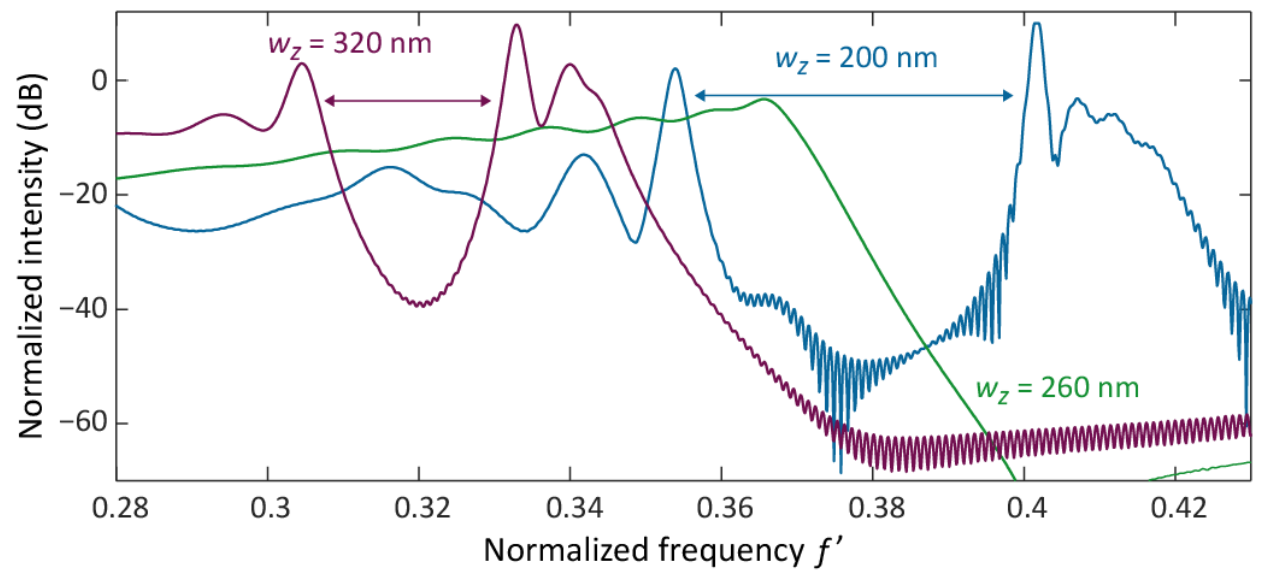
Figure 2. FDTD-calculated normalized intensity after transmission along a chain of 10 nanobricks using waveguides as input and output ports for w z = 200 (blue), 260 (black) and 320 nm (red). The results are normalized with respect to the transmission along a perfect rectangular waveguide. The trend is as follows: the PBG (highlighted by the horizontal lines with arrows) shifts to lower frequencies when w z increases and disappears at w z ≈ 260 nm.